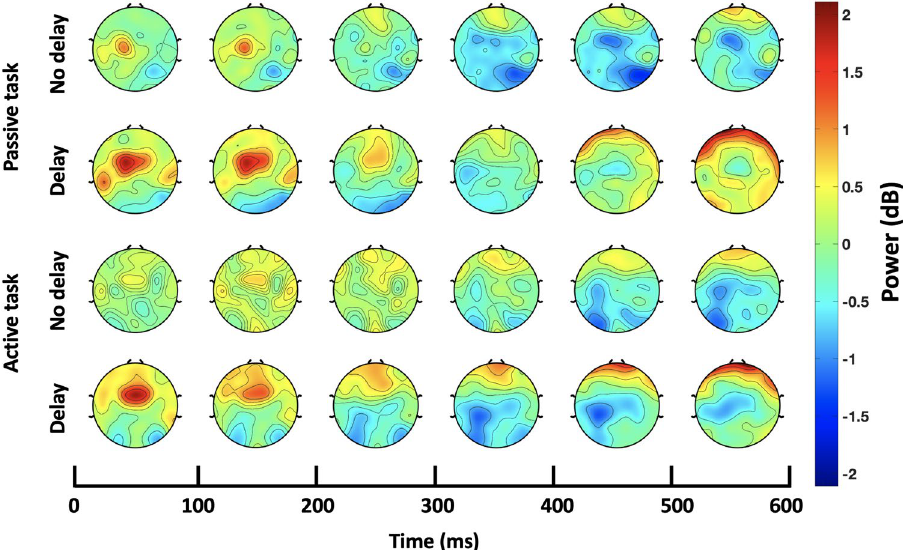
Figure 5. Time course of scalp topographies showing theta power during the passive and active tasks. The scalp topographies under the delayed and synchronous conditions are shown with a resolution of 100 ms. The onset at 0 ms corresponds to the haptic collision event. Theta activation in the midfrontal ROI is observed with a stronger intensity after the introduction of the haptic delay in both, the passive and active